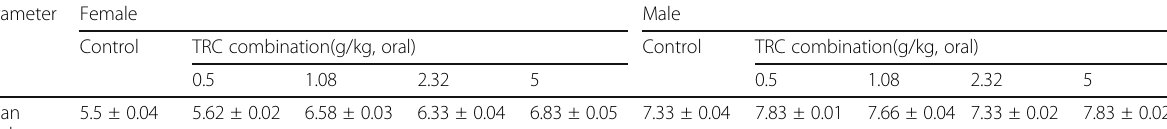
Table 6 food and water intake (AOT study) Parameter Female